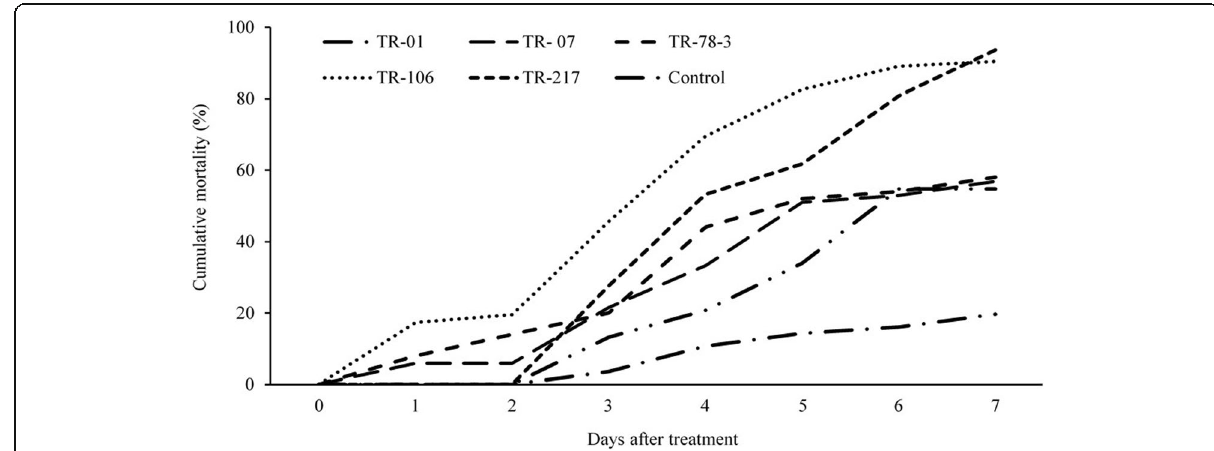
Fig. 4 Mortality rate of Sitophilus granarius treated with entomopathogenic fungi at 25 °C